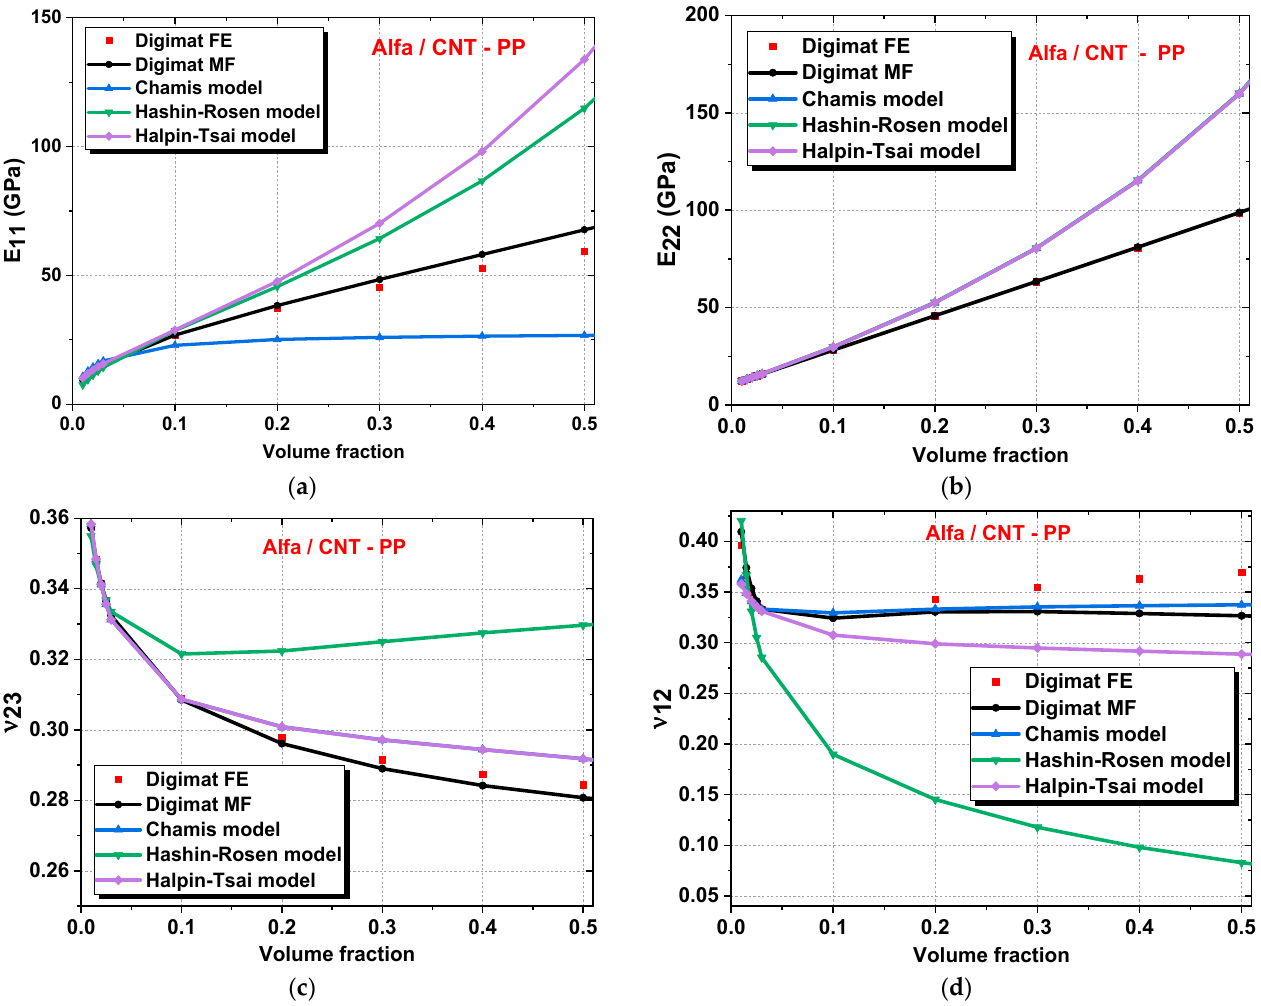
Figure 7. The transversely elastic moduli of CNT-PP matrix reinforced by alfa-aligned fiber, using numerical and analytical methods: ( a ) E 11 axial Young’s modulus; ( b ) E 22 in-plane Young’s modulus; ( c ) ν 23 in-plane Poisson’s ratio; and ( d ) ν 12 axial Poisson’s